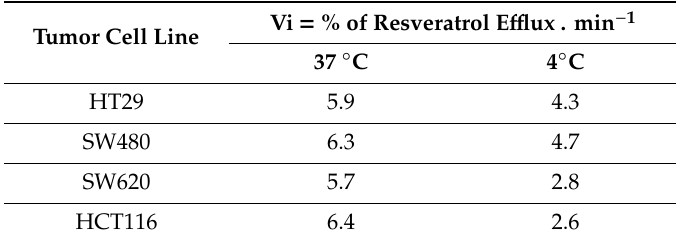
Table 1. Resveratrol e ffl ux rates in colon cancer cell lines as a function of